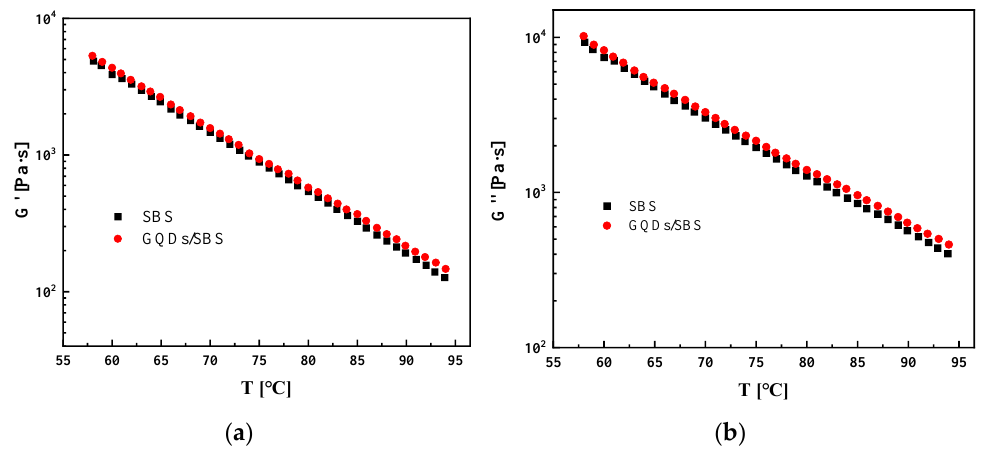
Figure 9. ( a ) Variation of storage modulus G′ with temperature and ( b ) Variation of loss modulus G″ with temperature.